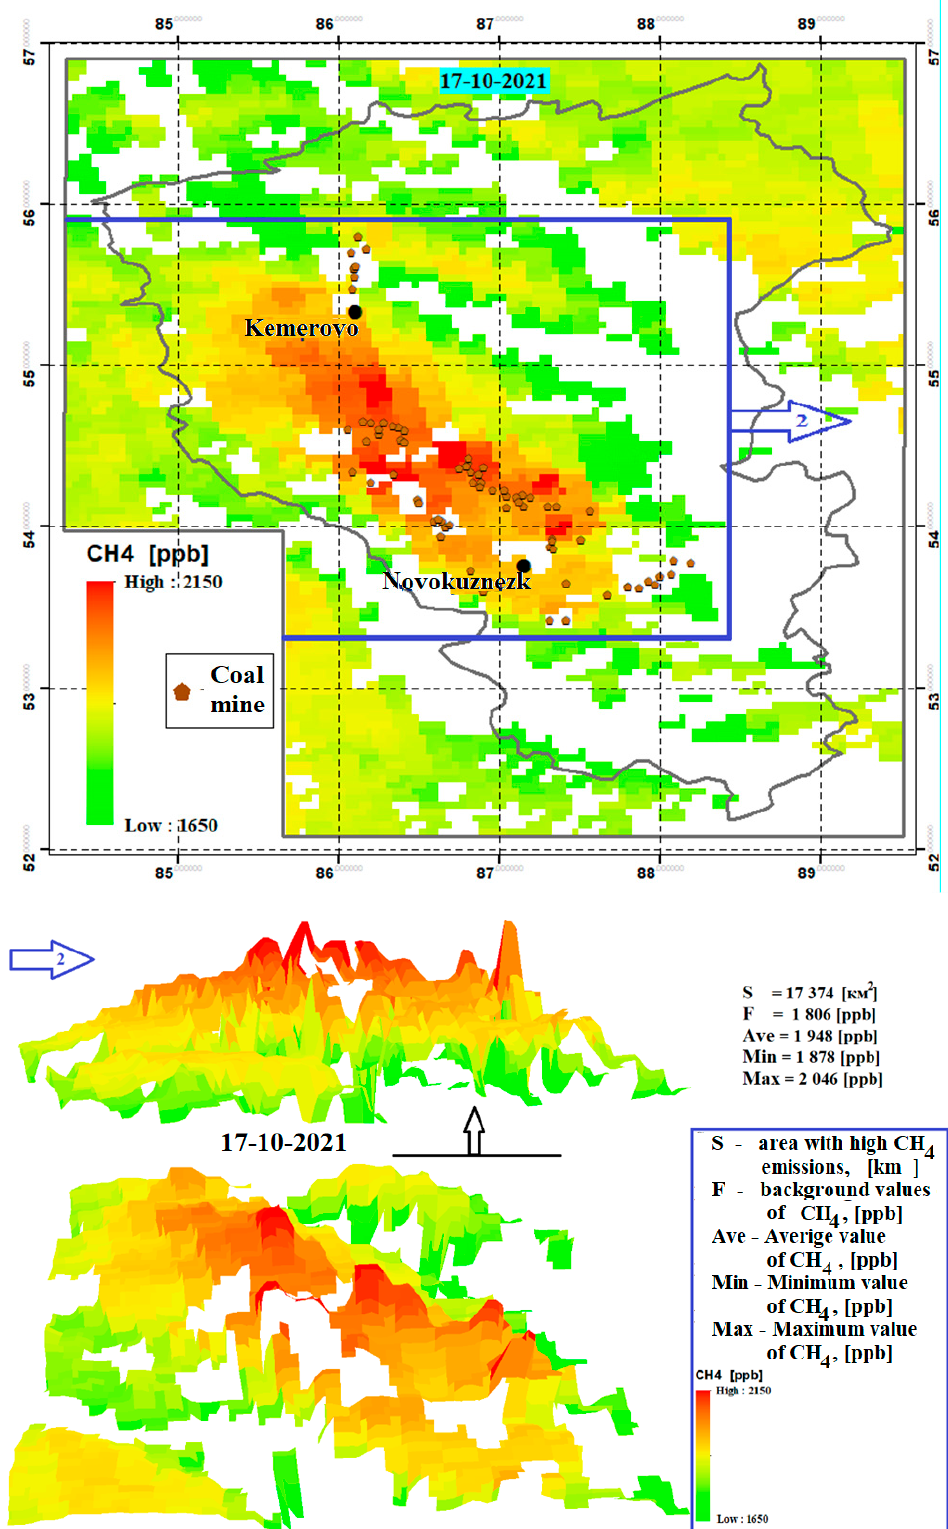
Figure 11. High methane emissions, registered on 17 October 2021. The blue rectangle ( top , 2D view) outlines the area shown in the 3D views ( bottom ). Data used—Sentinel-5P.